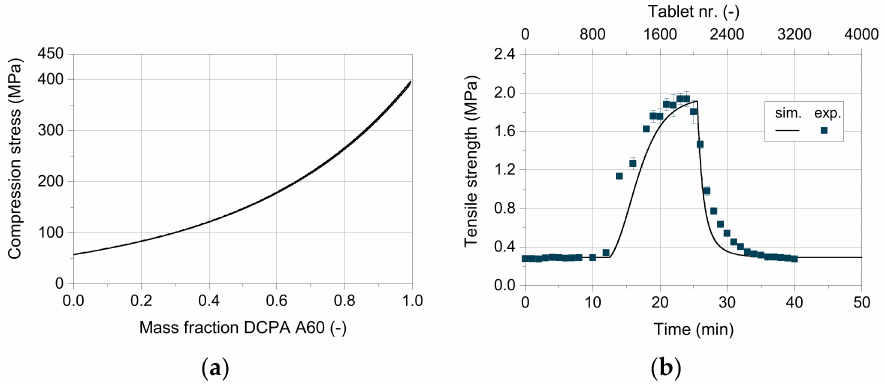
Figure 15. ( a ) Calculated compression stress over the mass fraction of DCPA A60. ( b ) Comparison of the simulative data with experimental results for the tensile strength. Table 8. Final agent-based simulation result deviations of critical quality attributes. Critical Quality Attributes Mean absolute relative error ( f )